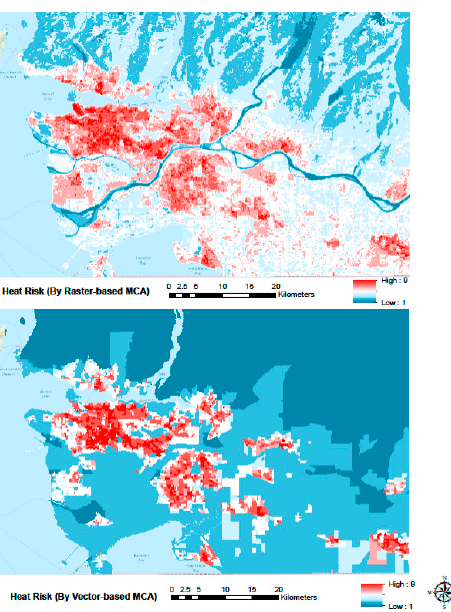
Figure 4. Heat risk maps from raster-based analysis ( Top ) and vector-based prediction ( Bottom ). Red indicates relatively high heat health risk, blue indicates relatively low heat health risk.